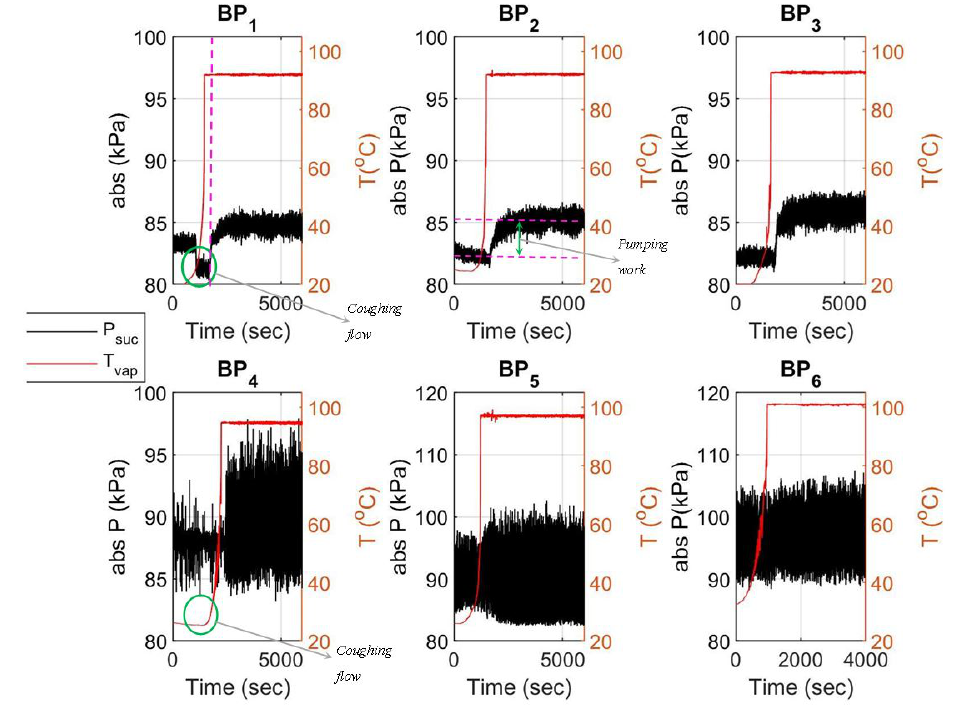
Figure 6. Pressure and temperature measured at secondary source for different back